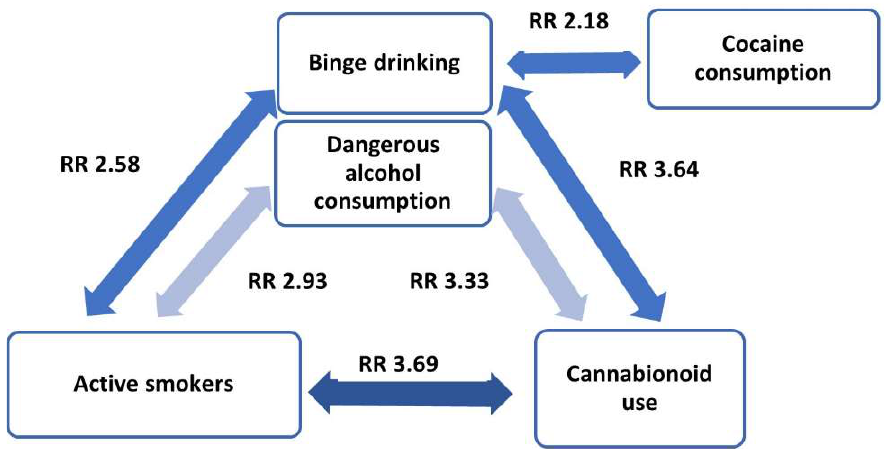
Figure 1. Relationships among toxic habits. Table 3. Health status ( n =